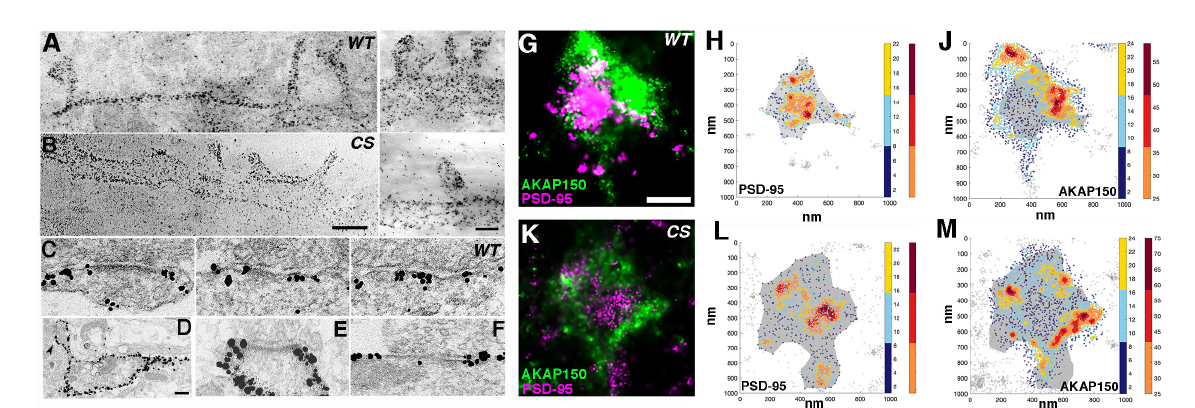
FIGURE1 Nano-scale distribution of AKAP79/150 in hippocampal neurons. ( A , left and B , left) Low magnification bright field scanning transmission electron microscopy (STEM) images of ∼ 1 µ m thick Epon embedded plastic sections of immunogold labeled endogenous AKAP150 in dissociated hippocampal mouse cultures with a home-made primary antibody showing extensive AKAP labeling at the dendritic and spine membrane. (A) Wild type mouse (WT). (B) Palmitoylation deficient knock-in mutant mouse (CS). Scale bar 600 nm. (A-right and B-right) Other examples of higher magnification STEM images of immunogold labeled endogenous AKAP150 in the membrane of spines and dendrites. A-right = WT, B-right = CS, Same samples as in ( A , left) and ( B , left), respectively. Scale bar 400 nm. Non-specific gold particles are 10 nm gold particles applied as fiducial makers for aiding tomography reconstructions. (C) Thin section transmission EM images of immunogold labeled endogenous AKAP150 in excitatory synapses in WT hippocampal mouse neurons. Scale bar 100 nm. (D–F) Thin section EM images of overexpressed AKAP79-GFP immunogold labeled for GFP in rat hippocampal neurons. (D) Low magnification EM micrograph shows extensive AKAP79-GFP immunogold labels in dendritic and extrasynaptic membrane. Arrowhead points to a spine synapse. Scale bar 300 nm. (E) AKAP79 labels stopped at the outer edge of the PSD at a spine synapse. (F) AKAP79 labels at a shaft synapse. Same scale as (C) . (G,K) d STORM images of endogenously labeled AKAP150 (CF568) and PSD95 (AF647). Rendered images of spines from a wild-type mouse (G) and palmitoylation-null AKAP150 CS knock-in mouse (K) d STORM AKAP150 localization shown in green and PSD-95 localization shown in magenta. Scale bar 250 nm. Scatterplot heatmaps of localizations of PSD-95 (H,L) or AKAP150 (J,M) . Wild-type data shown in (H,J) and CS data shown in (L,M) . The density-based PSD delineation is shown in gray as a reference in all scatter-maps. Color-scale represents the local density of each coordinate ( see section “Materials and methods” ). Localizations delineated as part of a high-density region (HDR) shown in hot colors (right color-bar). The AKAP150 HDRs are often clustered prominently at the periphery of the postsynaptic